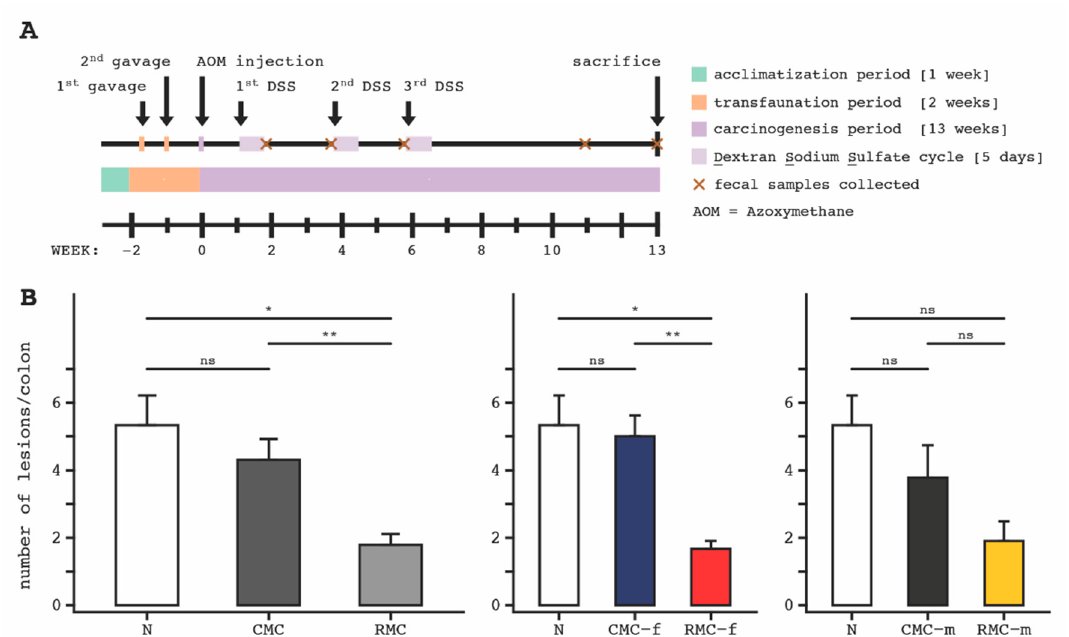
Figure 1. Study design and colon tumor outcomes following human fecal microbiota transplantation (FMT) in AOM-DSS treated mice. ( A ), Timeline for FMT gavage and AOM-DSS treatments to male and female mice. Murine feces was collected over time and tissues were harvested at 13 weeks for microbiota and metabolomics endpoint analyses. ( B ), Number of neoplastic lesions in entire colon tissue for mice receiving no microbial consortia, N ( n = 3), when compared to control microbial consortia (CMC) and rice bran modified microbial consortia (RMC) from human male (m) and female (f). The control ( n = 16 mice) and rice bran ( n = 19 mice) for both sexes combined for the human microbiota donors (left). The no treatment N ( n = 3); control microbiota consortia from female, CMC ‐ f ( n = 7) and rice bran modified microbiota consortia from female, RMC-f ( n = 9) (middle). 68.2% reduction in number of lesions for RMC-f compared to CMC-f. The no treatment, N ( n = 3); control microbiota consortia from male, CMC ‐ m ( n = 9); rice bran modified microbiota consortia from male, RMC ‐ m ( n = 10). 49.7% reduction in number of lesions for RMC ‐ m compared to CMC ‐ m (right). Error bars represent standard error of the mean; (*) indicates Benjamani–Hochberg adjusted p ‐ value < 0.05; (**) indicates Benjamani–Hochberg adjusted p ‐ value < 0.01; (ns) indicates Benjamani–Hochberg adjusted p ‐ value > 0.05.